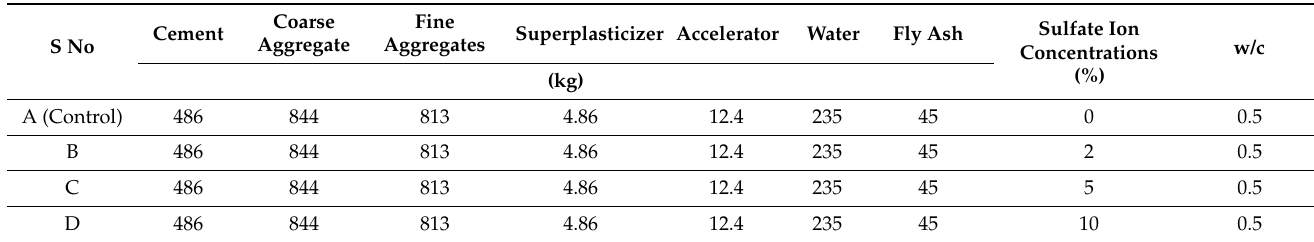
Table 3. Mixture proportion of shotcrete.